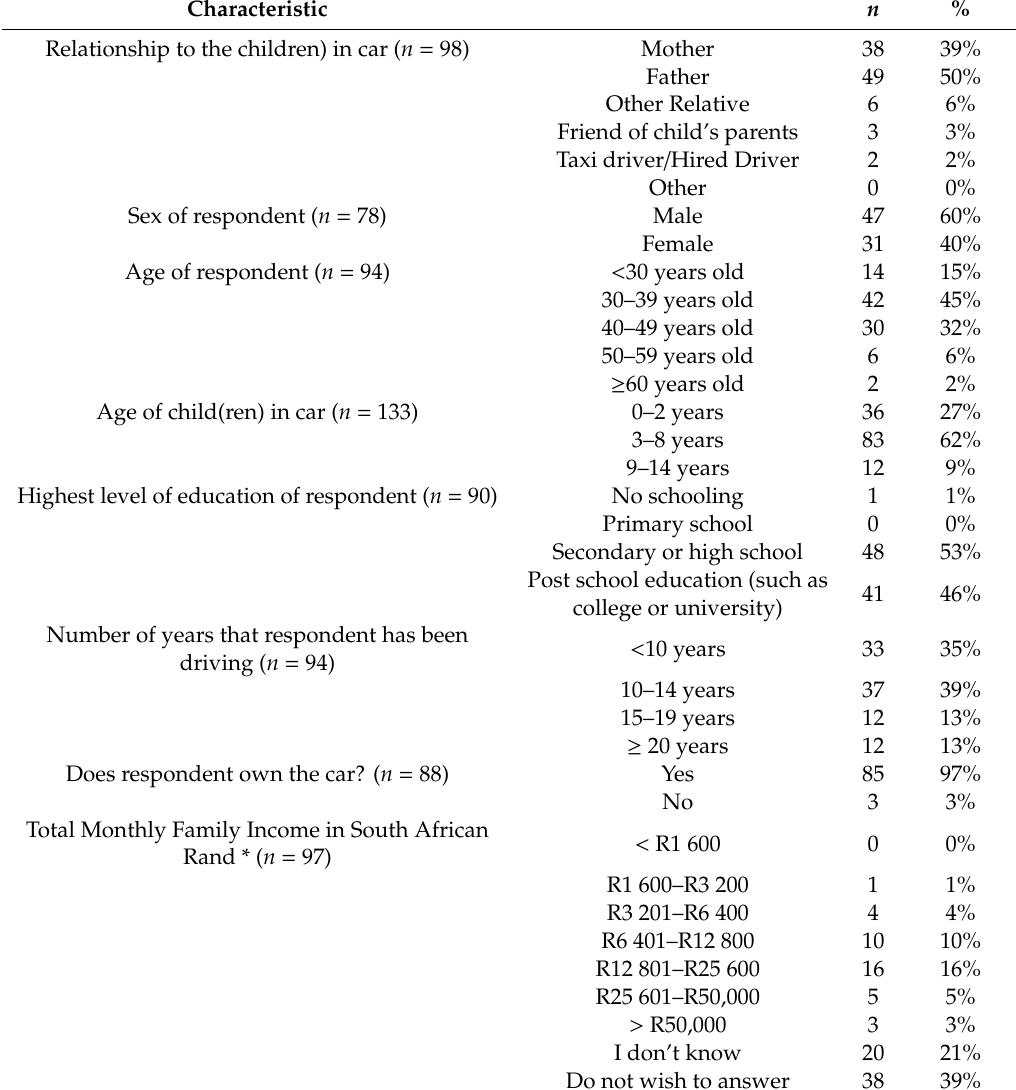
Table 4. Characteristics of Survey